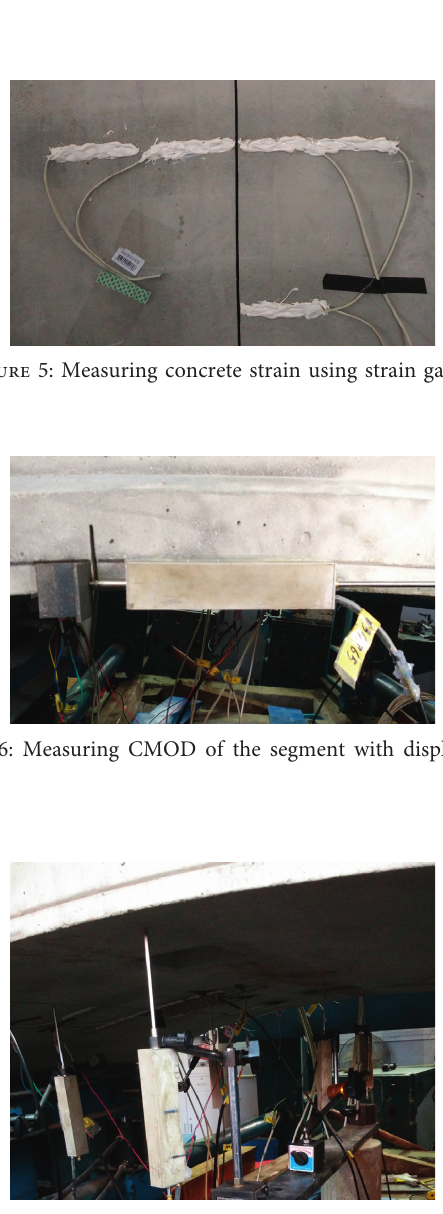
Figure 7: Measuring vertical displacement of the segment with displacement